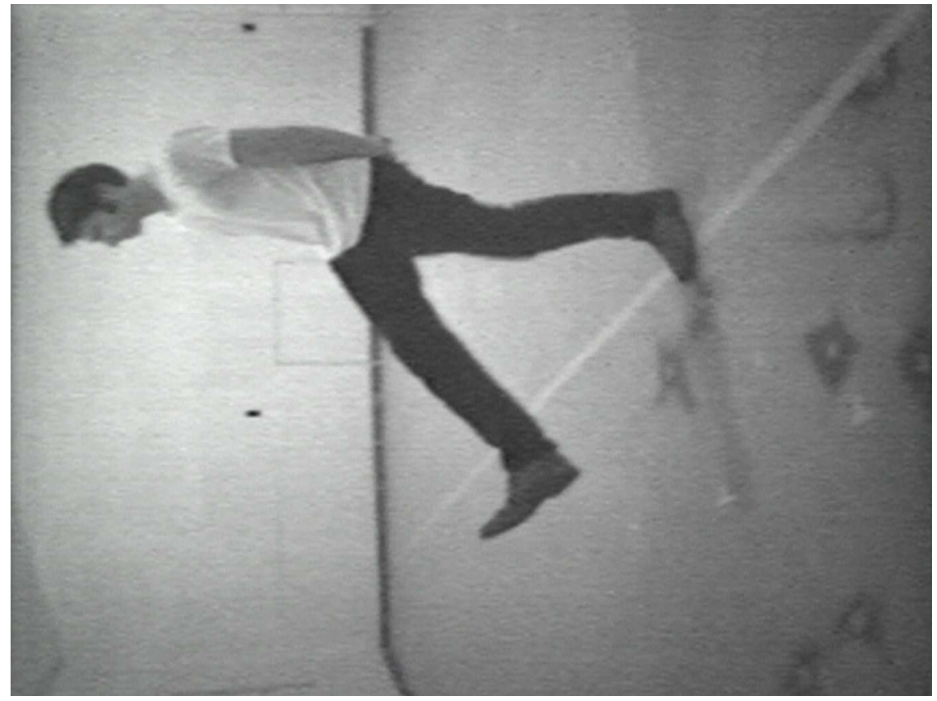
Figure 1. Bruce Nauman, Slow Angle (Beckett Walk) (1968) video [still